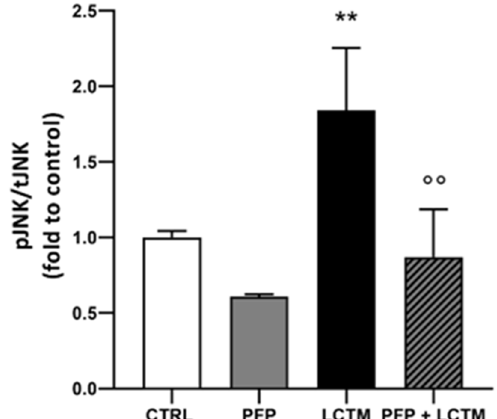
Figure 6. Effect of PFP (100 µg/mL) treatment on phosphorylation levels of JNK analyzed by ELISA assay in HaCaT cells unstimulated or exposed to LCTM for 60 min. Phospho-JNK levels (pJNK) were normalized on total JNK protein (tJNK). Each column represents mean ± SD. Data were analyzed by one-way analysis of variance followed by Tukey: ** p < 0.01 vs. CTRL; °° p < 0.01 vs. LCTM.